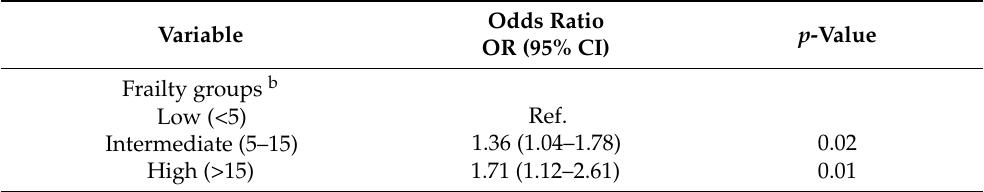
Table 3. Odds ratios (ORs) (multivariable analysis model 1 , all patients) for the probability of dying with COVID-19 within 30 days of diagnosis. N = 4312 cases of advanced cancer a , of which 282 died with COVID-19